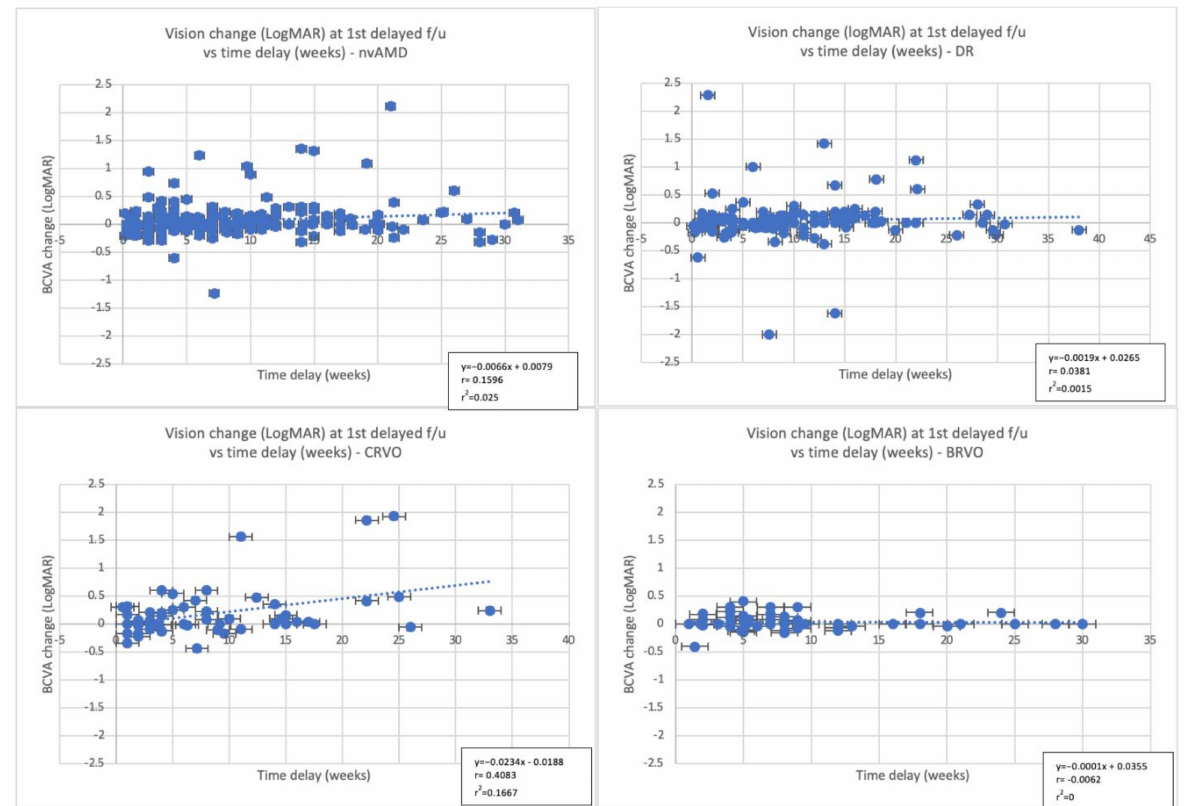
Figure 2. Regression analysis of the BCVA change (LogMAR) at actual f/u in patients who missed their intended f/u and time delay in weeks. Abbreviations: nvAMD: neovascular Age-related Macular Degeneration; DR: diabetic retinopathy; CRVO: central retinal vein occlusion; BRVO: branch retinal vein occlusion; BCVA: best corrected visual acuity; f/u: follow up; r = correlation coefficient; LogMAR: Logarithm of the Minimum Angle of Resolution. LogMAR of (+) 0.1 equals loss of 5